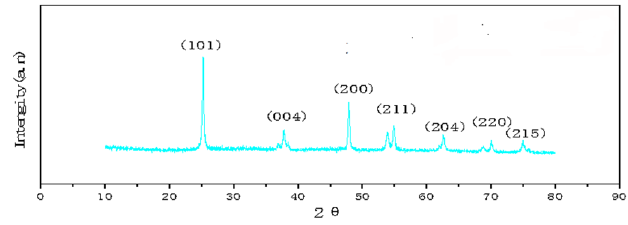
Figure 3. XRD patterns of GO/TiO 2 samples.